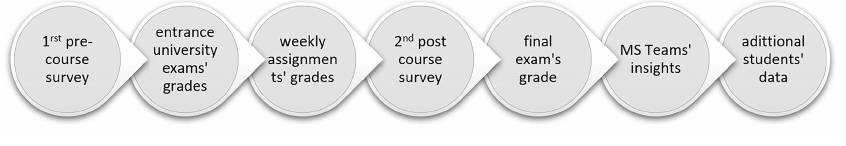
Fig. 1. The measuring